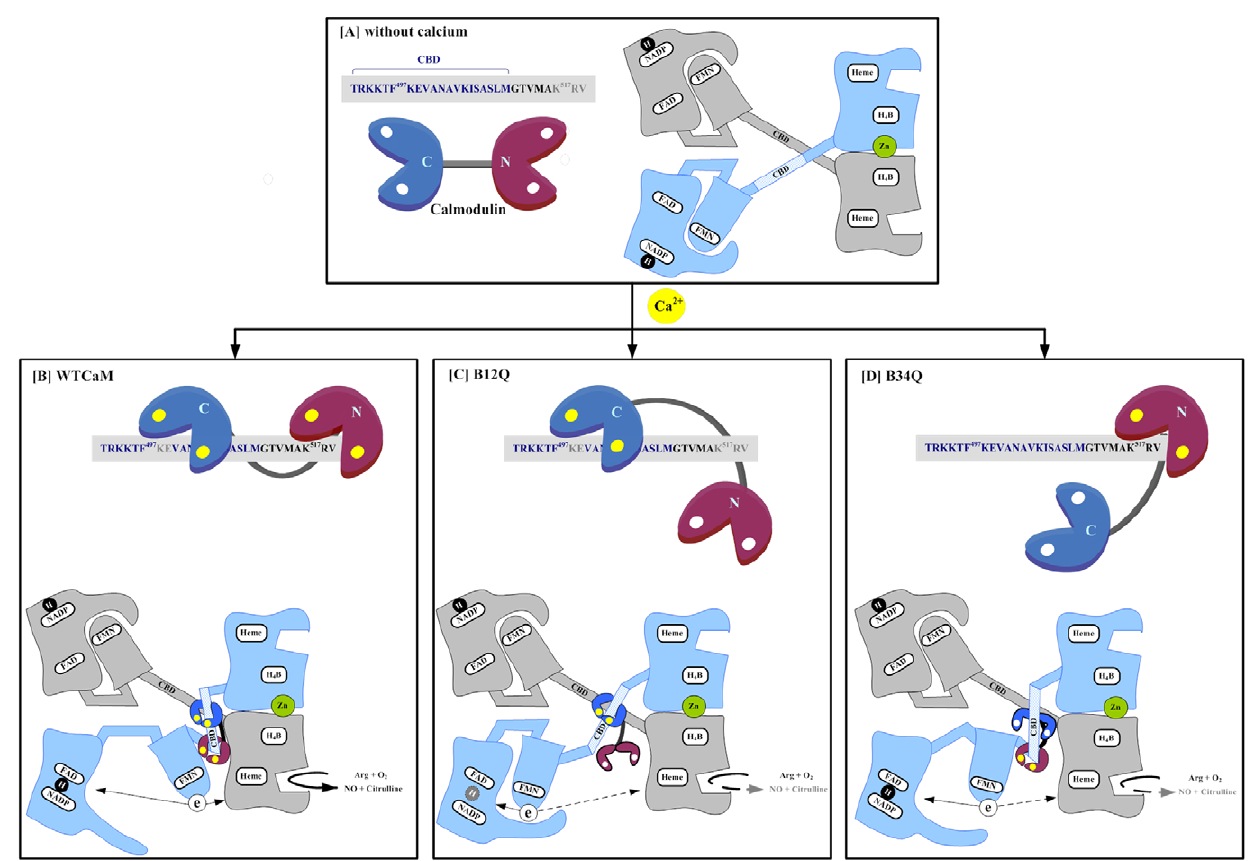
Figure 7. Schematic illustration of differential regulation of eNOS electron transfer by N- and C-terminal lobes of CaM. Dimeric eNOS model is derived from Daff [44]. The gray colored domains represent one subunit, and the sky-blue colored domains represent the other. The blocks indicate binding sites for heme, H 4 B, zinc, CaM, FMN, FAD and NADPH. The canonical CaM-binding domain (residues 491–510) between the FMN domain and the heme domain is denoted as CBD. CaM shown as two lobed structures N and C, joined by a flexible linker is adapted from Ref 45; apoCaM is marked with white circles and calcium binding is indicated by yellow circles. A: In the absence of calcium, apo-CaM is not associated with eNOS in which Lys497 is exposed to the trypsin digestion; the FMN domain is locked with FAD domain and electron flux is blocked. B: Upon calcium binding, wild-type CaM wraps around the eNOS CBD and potentially other sites with its two lobes bound. This binding protects Lys497 from tryptic cleavage and exposes Arg517 for trypsinolysis. Consequently, the FMN domain is released from the FAD domain, becoming accessible to the heme domain of the opposite subunit. C: With B 12Q mutation of N-lobe, calcium-bound C-lobe binds normally to CBD while the mutated N-lobe could not bind calcium and is unable to bring FMN domain to the heme domain of the other subunit which hinders electron transfer as illustrated by a dotted line. D: With B 34Q mutation of C-lobe, C-lobe is unable to bind CBD which retards electron transfer.